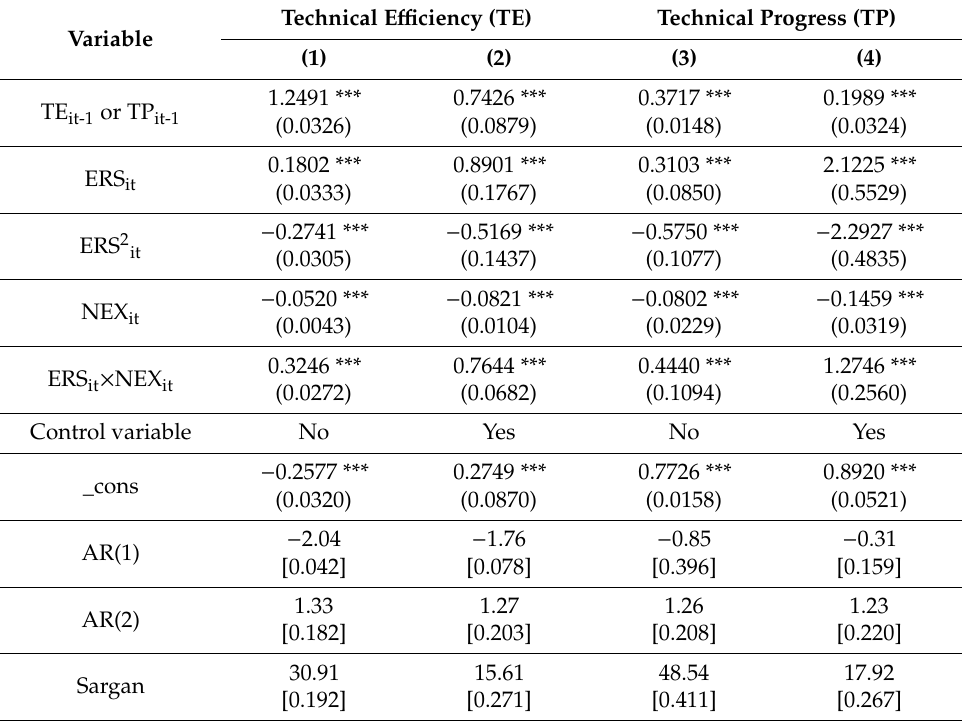
Table 3. The robustness test results after replacing the explanatory variables.